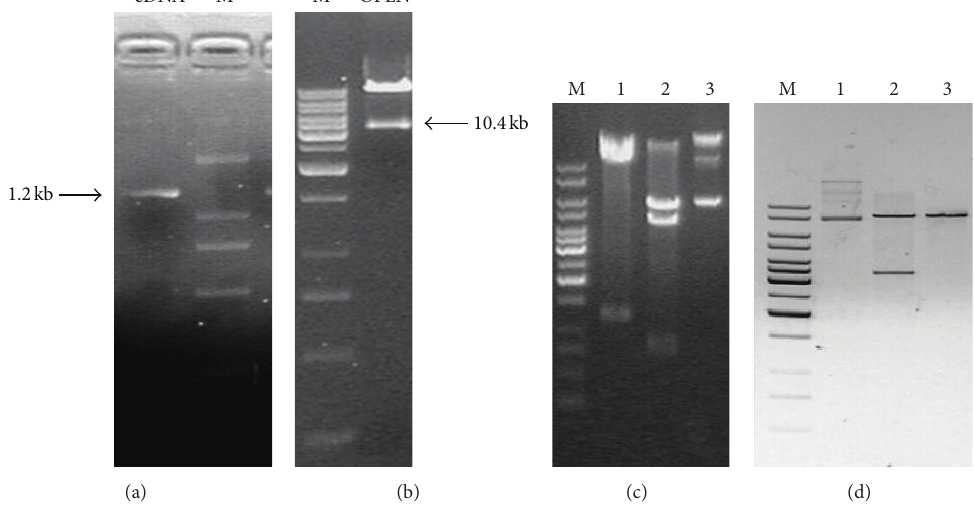
Figure 2: Recombinant PCI-hOPGp-mOPG plasmid construction and plasmid linearization. (a) mCPG DNA was digested by Not